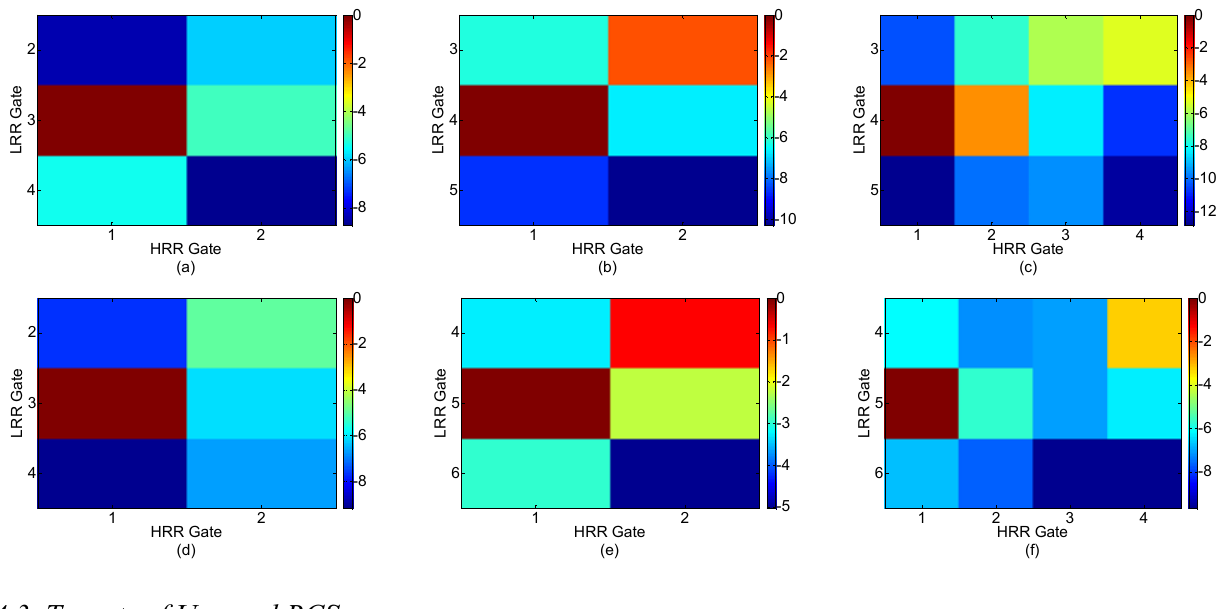
Figure 16. HRR Images for a Target Scenario 7. ( a ) Pass 2, Target scene 1. ( b ) Pass 2, Target scene 2. ( c ) Pass 3, Target scene 2. ( d ) Pass 2, Target scene 3, LRR gate 3. ( e )